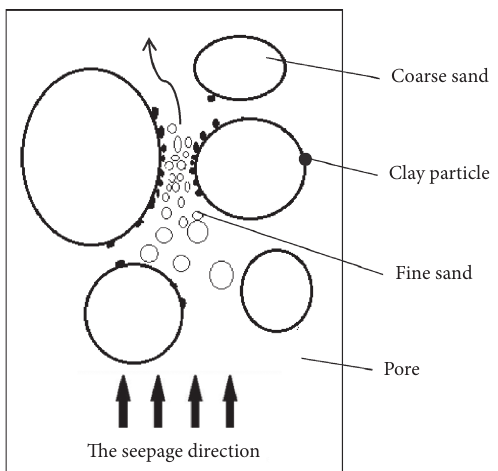
Figure 16: Schematic diagram of the migration of fine sand of clay- sand-gravel